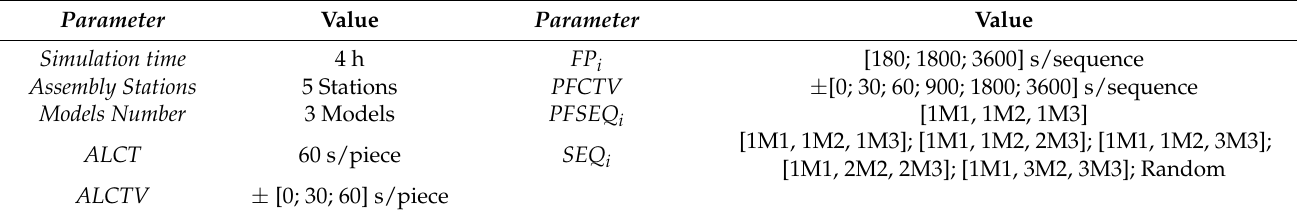
Table 2. Simulation